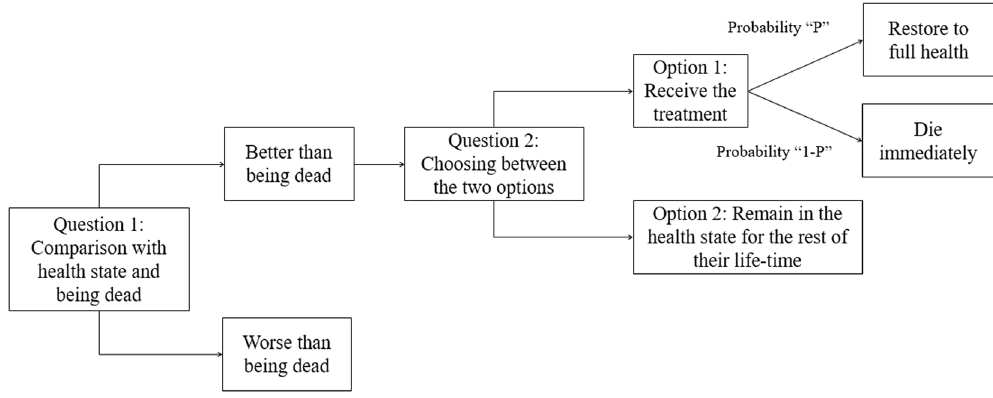
Figure 2. Flow chart of standard